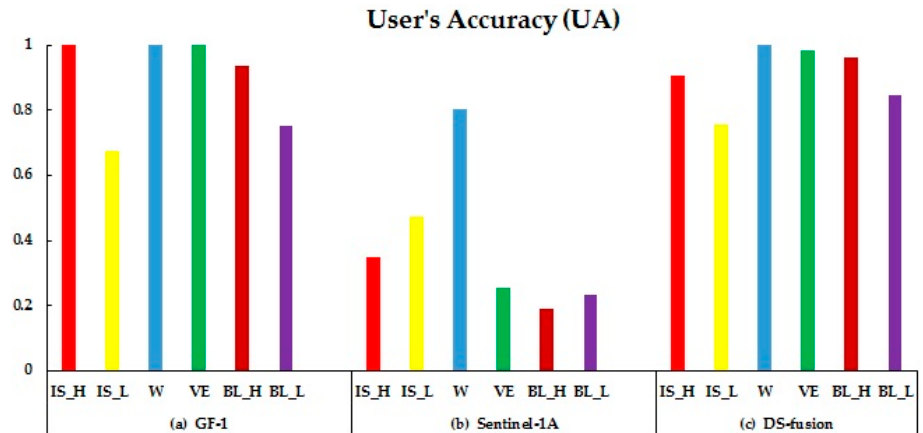
Figure 8. The user’s accuracy of land cover types extracted from different data sources. ( a ) The user’s accuracy of land cover types extracted from GF-1 image; ( b ) The user’s accuracy of land cover types extracted from Sentinel-1A image; ( c ) The user’s accuracy of land cover types extracted from fusing the GF-1 and Sentinel-1A image.